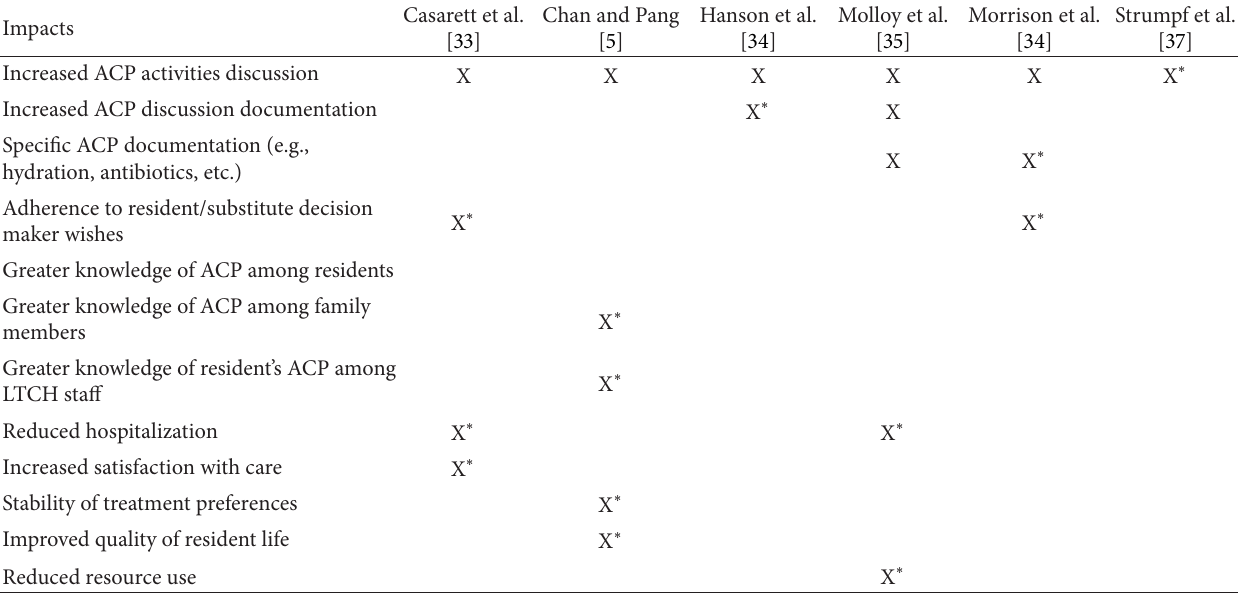
Table 3: Summary of the reported impacts of the ACP